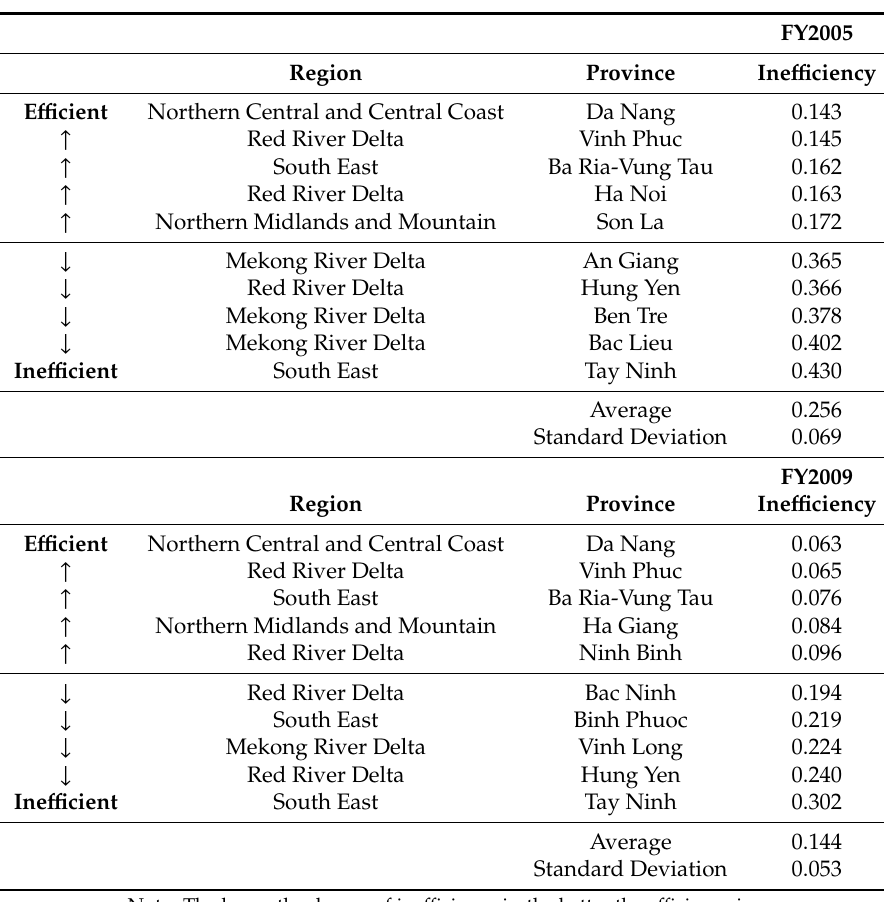
Table 3. Degree of ine ffi ciency in FY2005 and